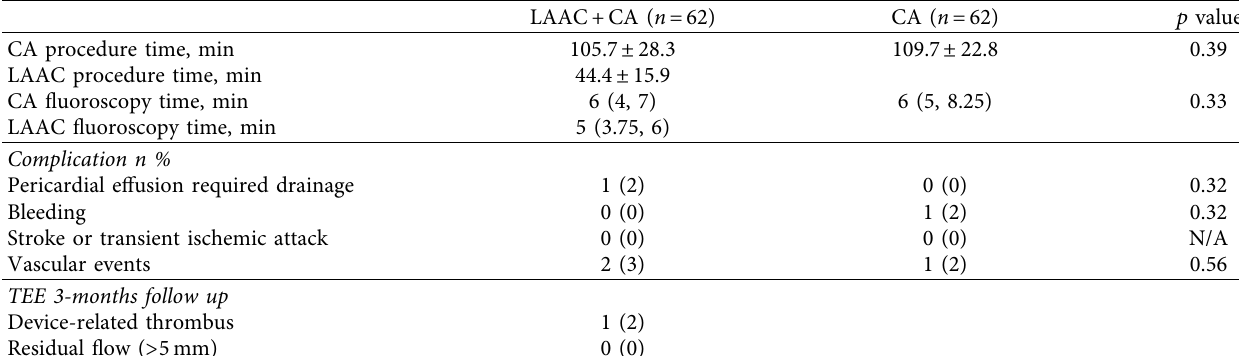
Table 3: Periprocedural characteristics and postoperative